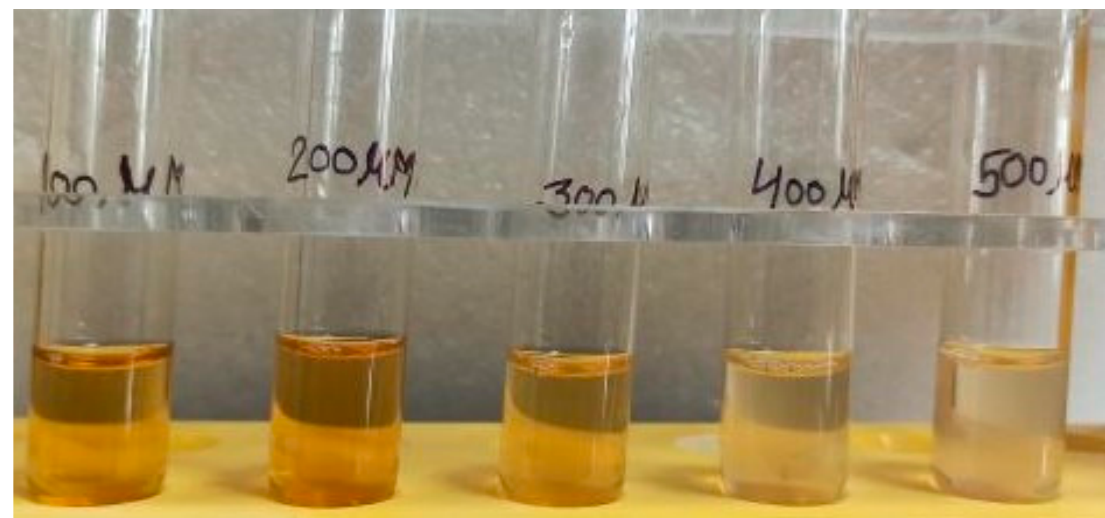
Figure 18. Image displaying reaction between Fe 3+ ions (100 µM to 500 µM) as synthesized AgNPs.